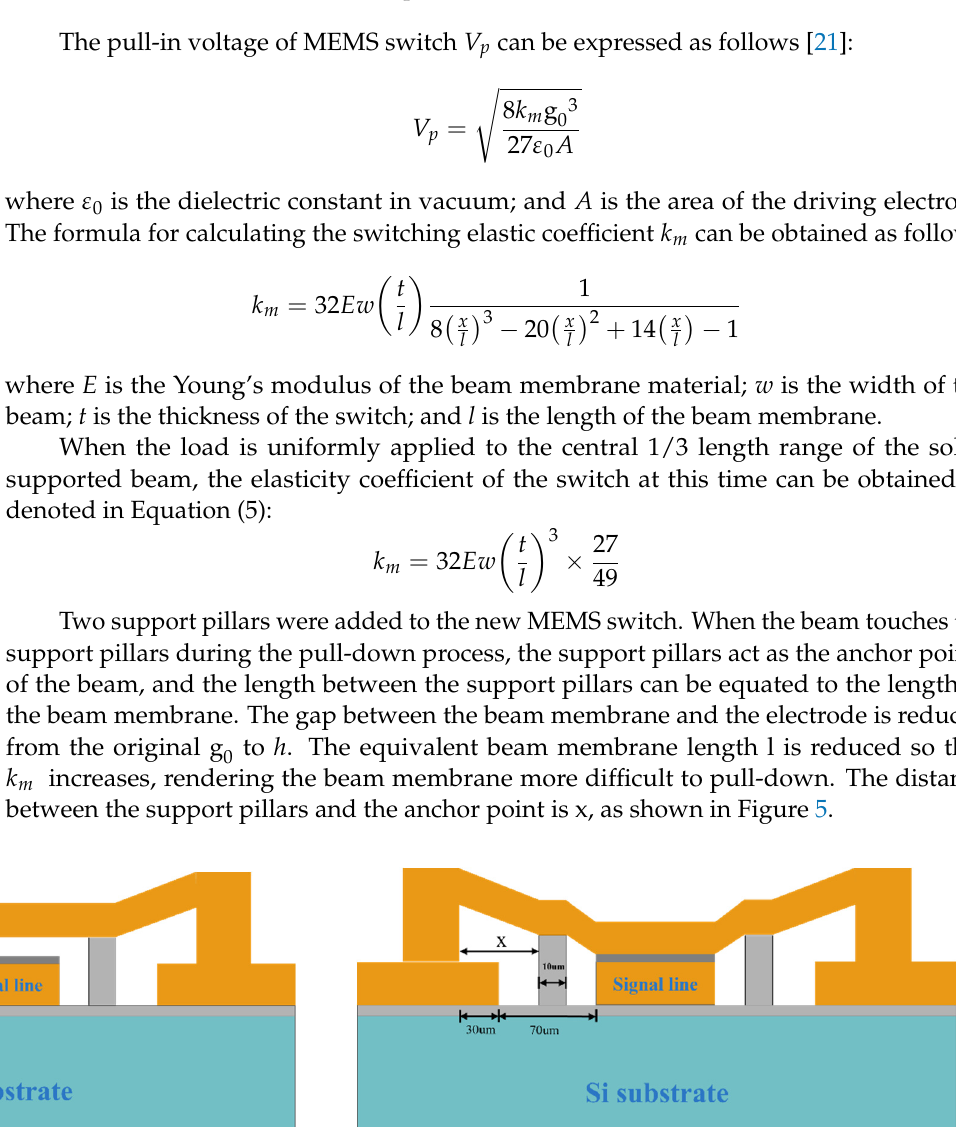
Figure 4. MEMS Switch Parallel Plate Equivalent Model.